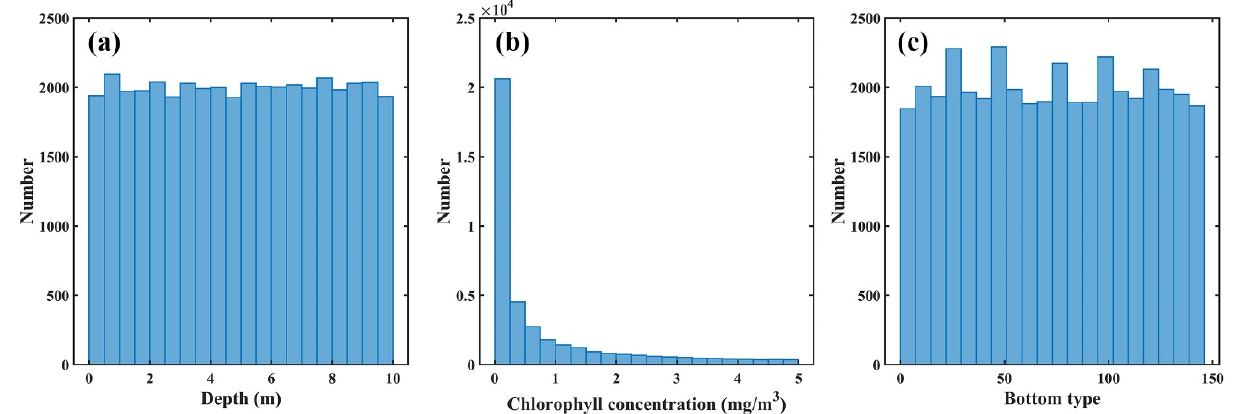
Figure 3. The distribution histogram of ( a ) depth; ( b ) chlorophyll concentration; ( c ) bottom type. Table 2. Detailed Setups for the Hydrolight Simulation.